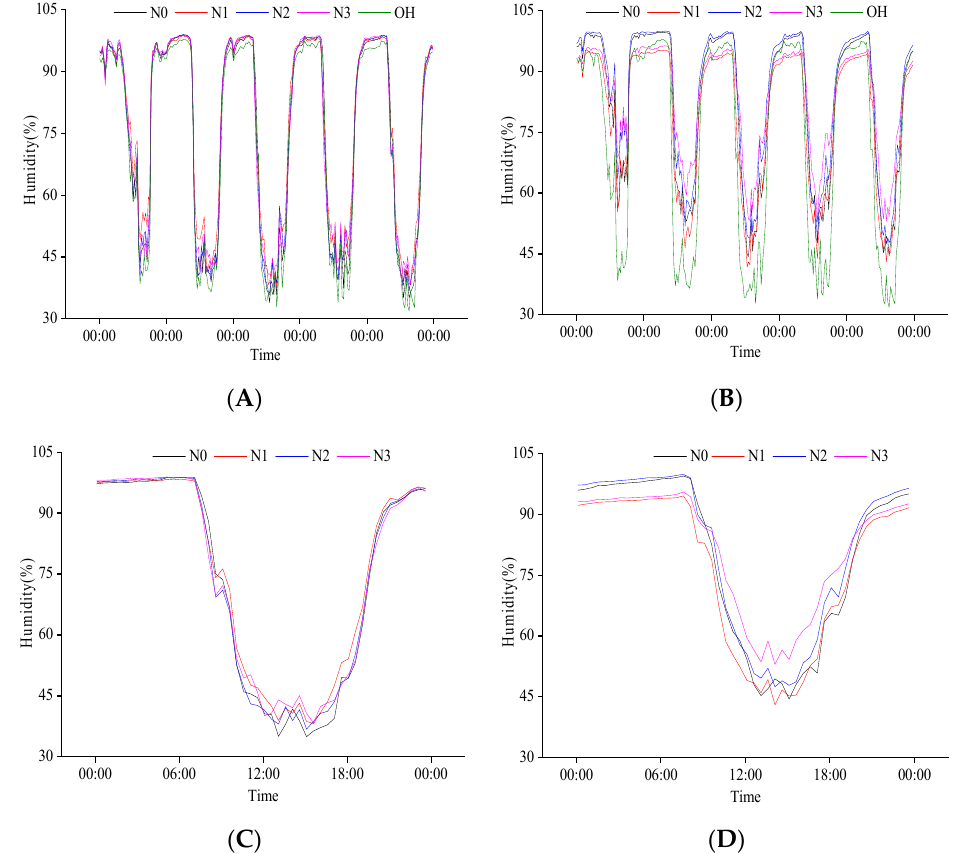
Figure 5. Daily variation in population humidity at grain filling stage. ( A ) Canopy humidity of population from 16 August to 20 August; ( B ) Baselayer humidity of population from 16 August to 20 August; ( C ) Canopy humidity of population on 20 August; ( D ) Baselayer humidity of population on 20 August. OH is the change in external humidity, N0, N1, N2, and N3 are the effects of different nitrogen fertilizers on population humidity under P1 conditions.